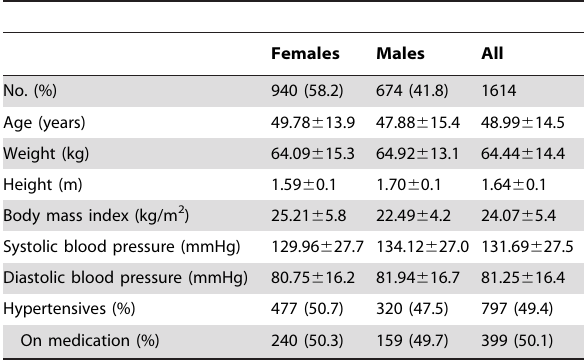
Table 1. Descriptive characteristics of phenotypes among study participants.